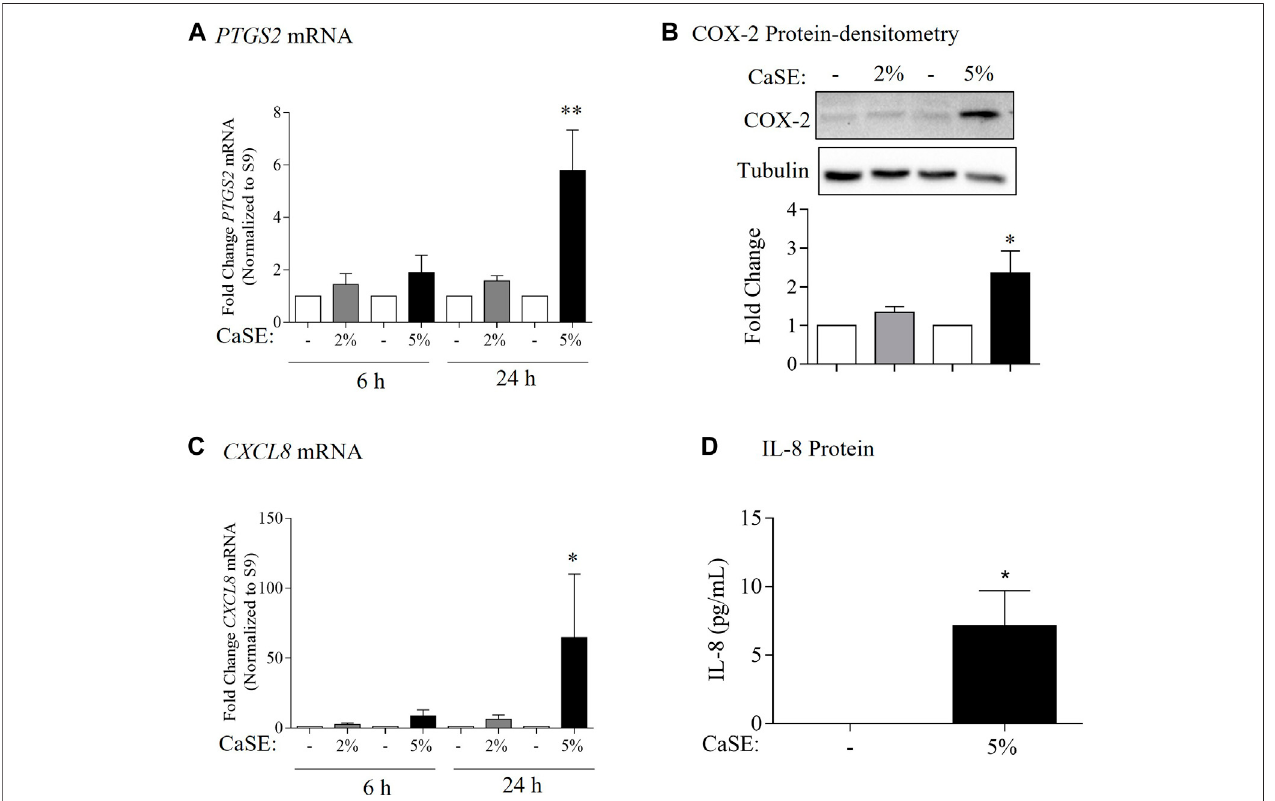
FIGURE 6 | CaSE induces COX-2 and IL-8 expression in human lung fi broblasts. (A) . PTGS2 mRNA: there was a slight increase, but not statistically signi fi cant, in PTGS2 mRNAinHLFsexposedto2and5%CaSEfor6 handinHLFsexposedto2%CaSEfor24 hcomparedtocorrespondingcontrol.Therewassigni fi cantincrease in PTGS2 mRNA in HLFs exposed to 5% CaSE for 24 h (** p = 0.009) compared to corresponding control. Results are expressed as the mean ± SEM of 4 independent experimentsofHLFsusedfrom3Normalsubjects. (B) .COX-2Protein-densitometry:therewassigni fi cantincreaseinCOX-2proteinlevelsinHLFsexposedto5% CaSE for 24 h (* p = 0.04) compared to corresponding control. Results are expressed as the mean ± SEM of 3 independent experiments (HLFs used from 3 Normal subjects). (C) . CXCL8 mRNA: there was a slight -but not statistically signi fi cant-increase in CXCL8 mRNA in HLFs exposed to 2 and 5% CaSE for 6 h There was signi fi cantincreasein CXCL8 mRNAinHLFsexposedto5%CaSEfor24 h(* p =0.01)comparedtocorrespondingcontrol.Resultsareexpressedasthemean±SEMof 4 independent experiments (HLFs used from 3 Normal subjects). (D) . IL-8 Protein: there was an increase in IL-8 protein levels in the media from HLFs exposed to 5% CaSE for 24 h compared to corresponding control. Results are expressed as the mean ± SEM of 3 independent experiments (HLFs used from 3 Normal subjects).